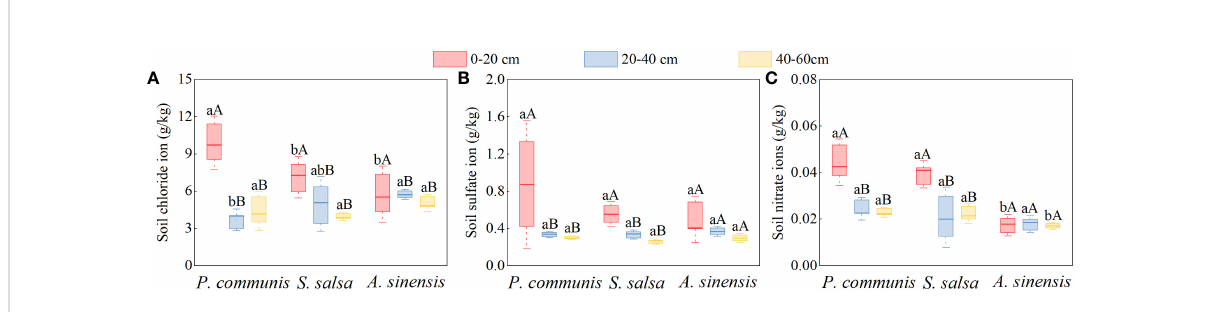
FIGURE 7 Cl- (A) , SO42- (B) , NO3- (C) anion content in soils of halophyte. Capital letters indicate the difference between different organs in the same halophyte, and lowercase letters donate the difference of different halophytes of the same organ (P <